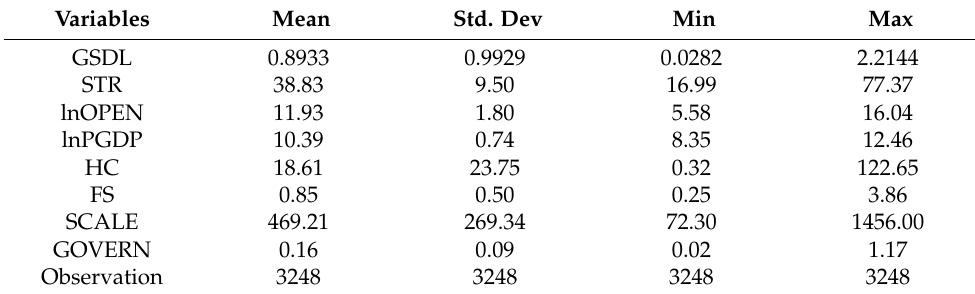
Table 2. Descriptive statistics of variables.